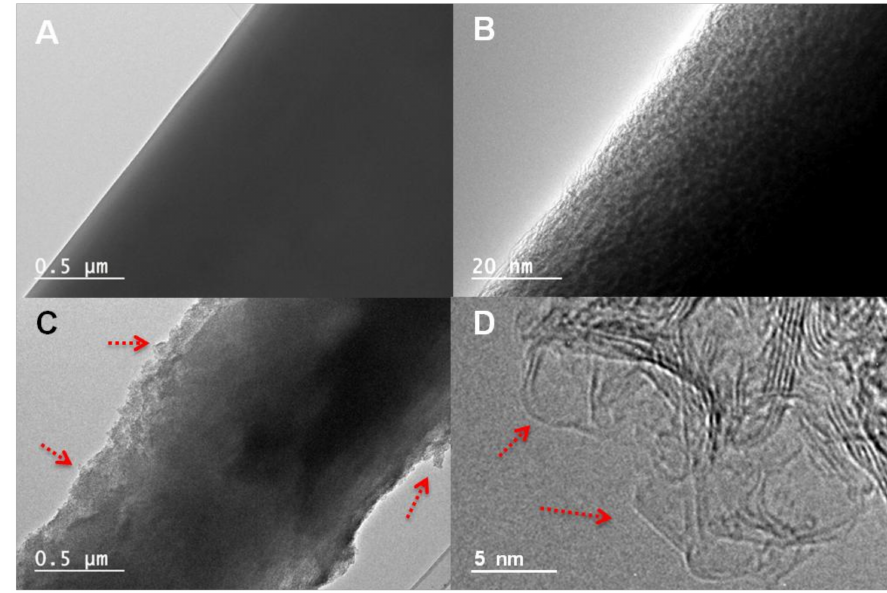
Figure 6. Transmission electron microscopy (TEM) images of GFs ( A , B ) and OGFs-24 ( C , D ). Surface defects generated on the OGFs are indicated by